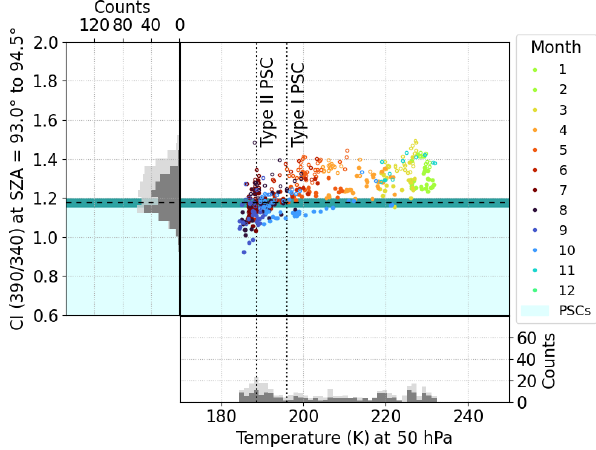
Figure 7. Colour index (CI) in the UV of the year 2007 for the Neumayer measurements. Data are plotted against ECMWF tem- perature at 50hPa and colour-coded for the respective month of the measurement. The temperature thresholds for the formation of Type I and II PSCs are indicated by the dashed lines. The histograms de- pict the distribution of data points for the CI (left panel) and the temperature (bottom panel). Light grey distributions correspond to the unfiltered data; dark grey distributions represent the data filtered for tropospheric clouds, i.e. high O 4 DSCDs as detailed in the Ap- pendix A. Likewise, the unfilled circles indicate data points that may be cloud-contaminated. The blue shaded area comprises the PSC cases. The error margin of the CI threshold is shaded in turquoise.